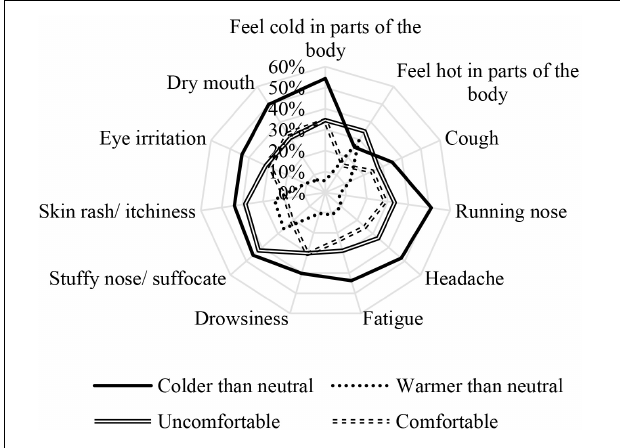
FIGURE 8 | Ratio of symptom reports between TSV and